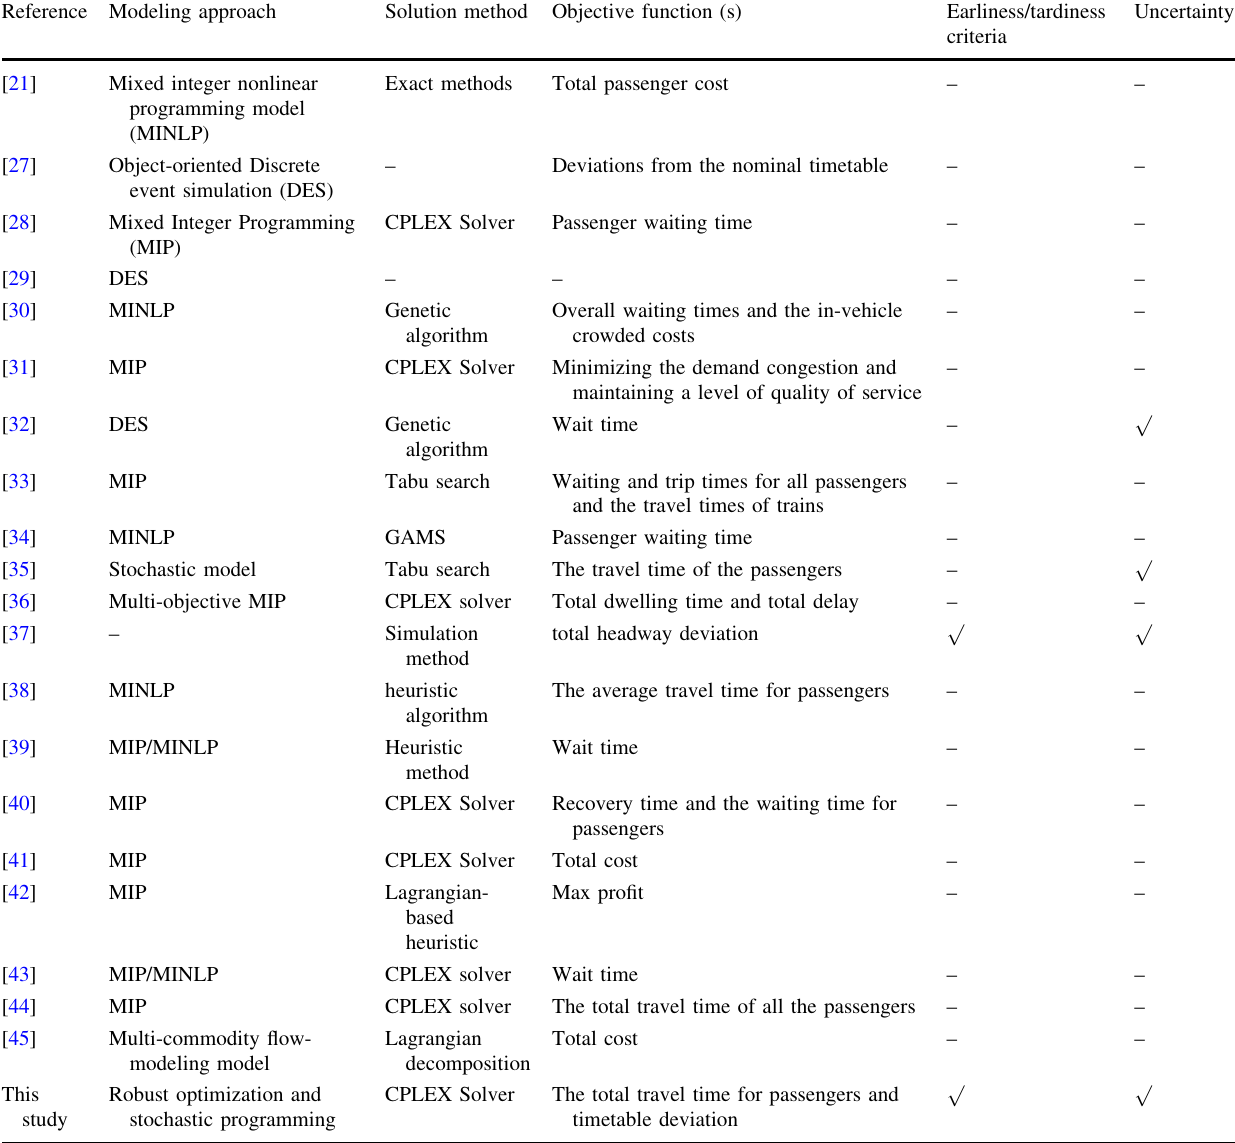
Table 1 A classification of the existing skip-stop scheduling models in rail rapid transit systems Reference Modeling